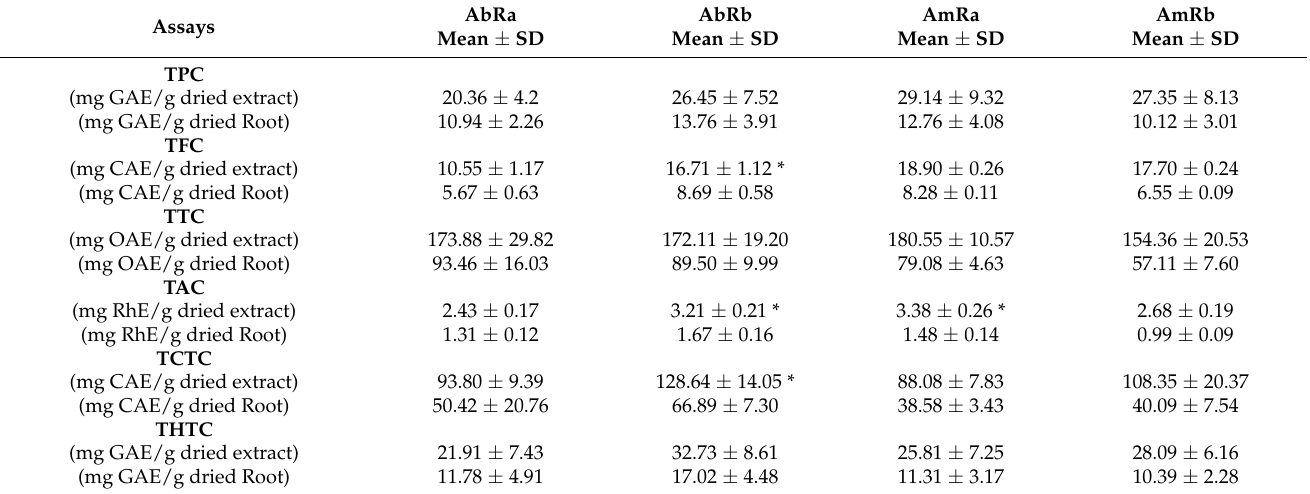
Table 2. Quantification of principal chemical classes of A. bento-rainhae and A. macrocarpus root tuber extracts.